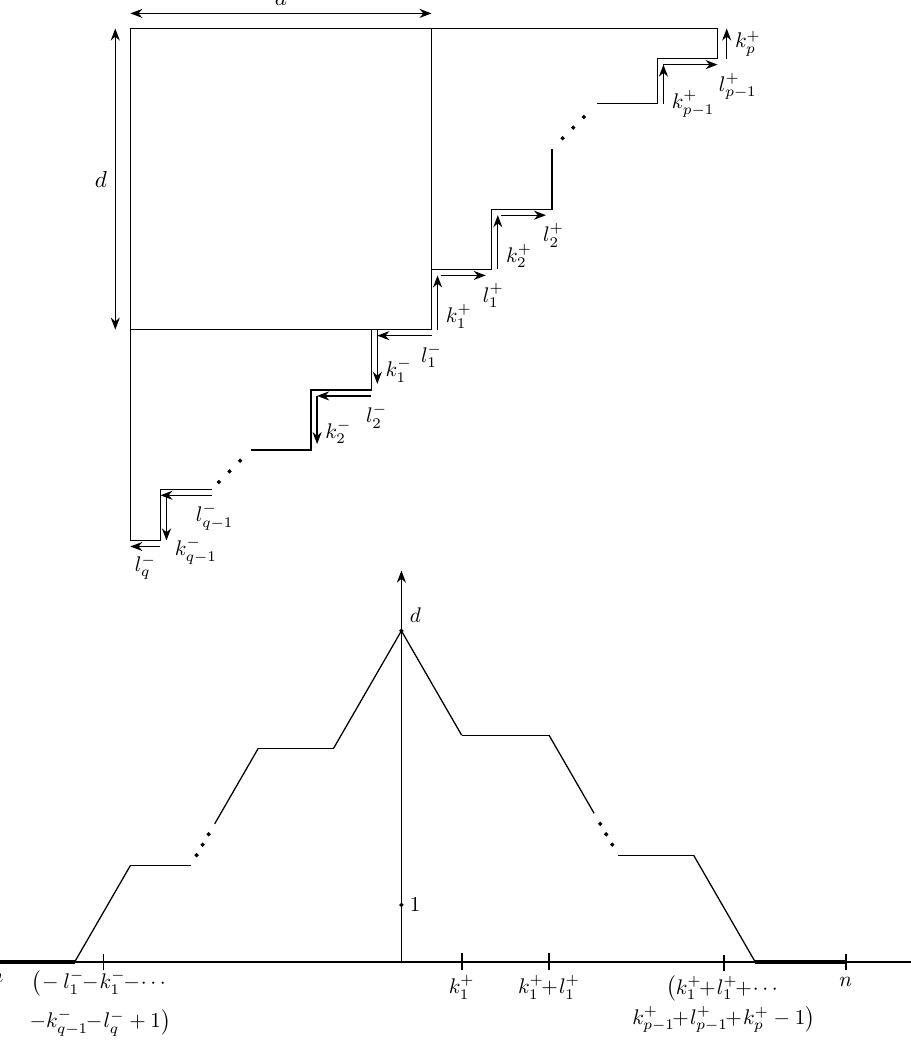
Figure 7 . Above: Young diagram being speci(cid:12)ed by the parameters d; k + a typical content distribution plot. The content of the boxes along the main diagonal is c = 0 and its multiplicity is d . The content of the box at the top right most corner of the diagram is k + + l + + k + 1 and its multiplicity is 1. Similarly, the content of the box at the bottom left p (cid:0) 1 1 (cid:1) (cid:1) (cid:1) most corner is l (cid:0) k (cid:0) l (cid:0) + 1 also with multiplicity of 1. At the end points of n and q 1 (cid:0) 1 (cid:0) (cid:1) (cid:1) (cid:1) CDF open string is at zero for all Young diagrams.